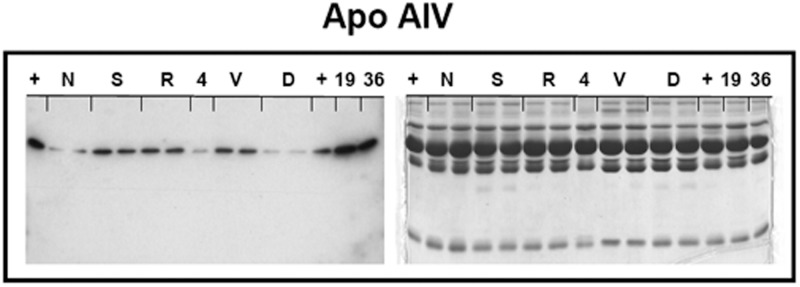
Representative Western blot of Apo AIV in human plasma of SBS patients and healthy subjects.After blotting (left membrane), gel proteins were stained with Coomassie blue (right) to ensure that the same amount of diluted plasma (1/50) was loaded in each lane. Samples were processed per duplicate in SDS-PAGE gel (right). Five SBS patients (codes: ‘N’, ‘S’, ‘R’, ‘V’ and ‘D’) and three individuals from the control group (codes: ‘4’, ‘19’ and ‘36’) were analyzed. Plasma (+): was used as internal control (100 AU).